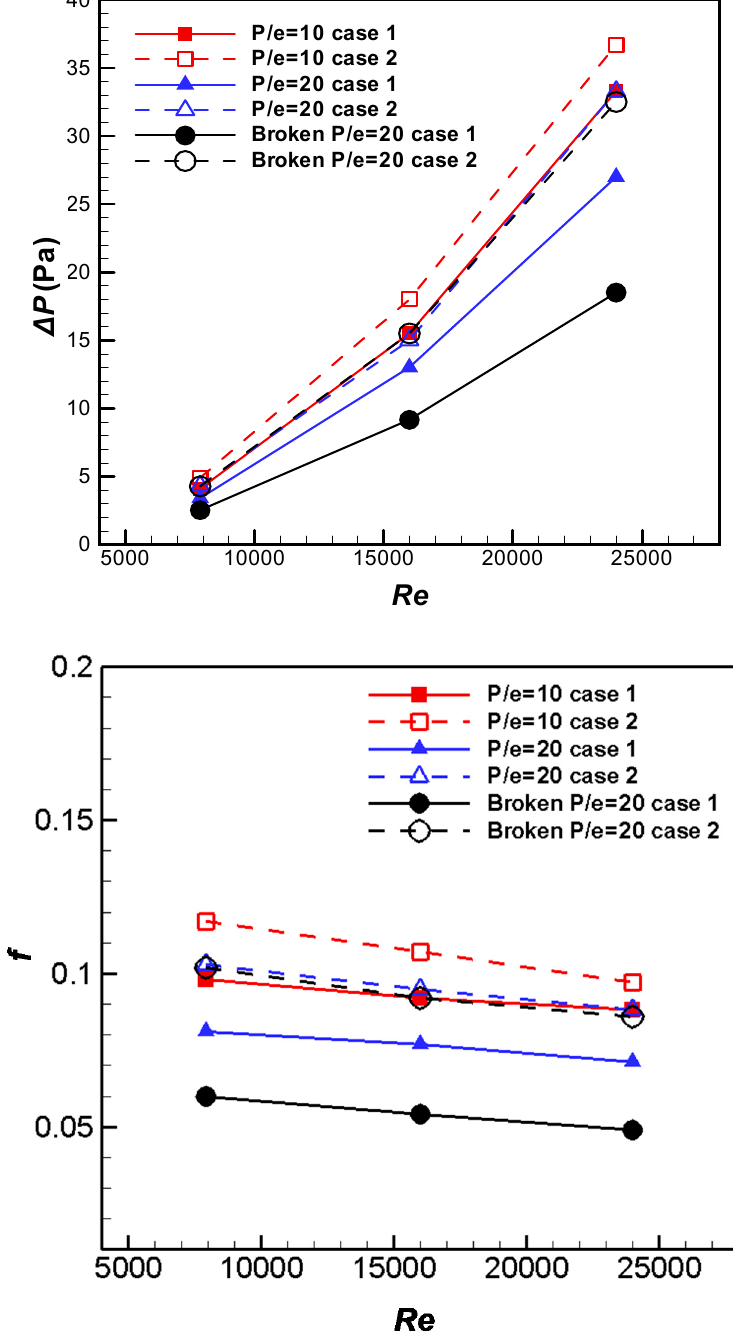
Figure 13. Pressure drop and Friction factor.